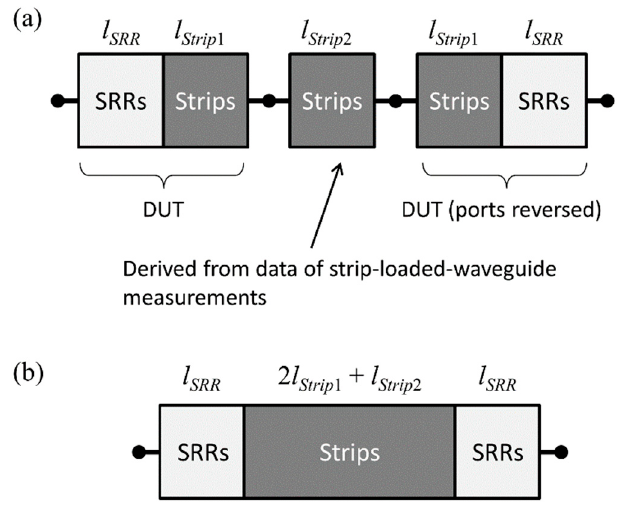
Figure 3. Block diagram of the tunneling identification method: ( a ) constituent elements, and ( b ) equivalent structure.